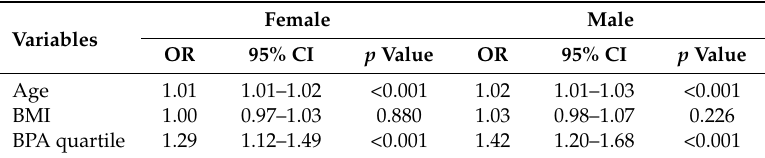
Table 3. Logistic regression analyses: predictors for TPOAb positive by sex.